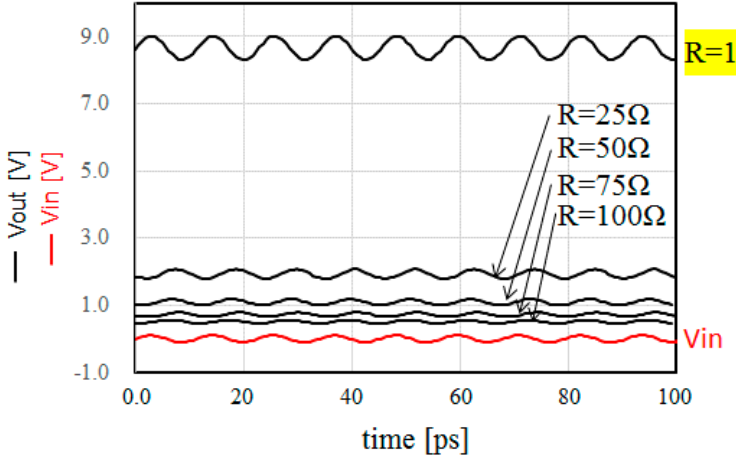
Figure 5. Transient simulation of the output voltage with different antenna impedances.